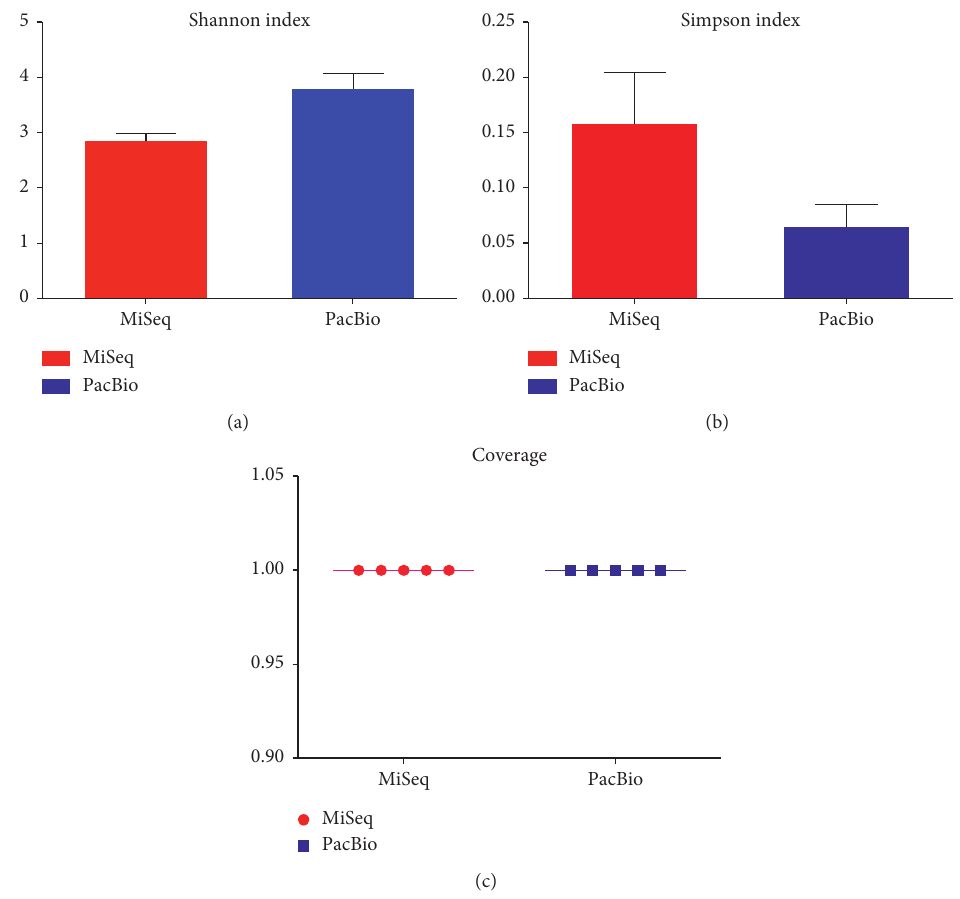
Figure 4: Comparison of α -diversity and coverage between MiSeq and PacBio platforms. (a) Shannon index, which can reflect how many OTUs there are in saliva and simultaneously take into account how evenly the OTUs are distributed among the oral microbiome. (b) Simpson index, which is used to measure the degree of concentration when oral microbiota are classified into OTUs. (c) Coverage, which is calculated from the length of the original genome ( G ), the number of reads ( N ), and the average read length ( L ) as N ∗ L / G .